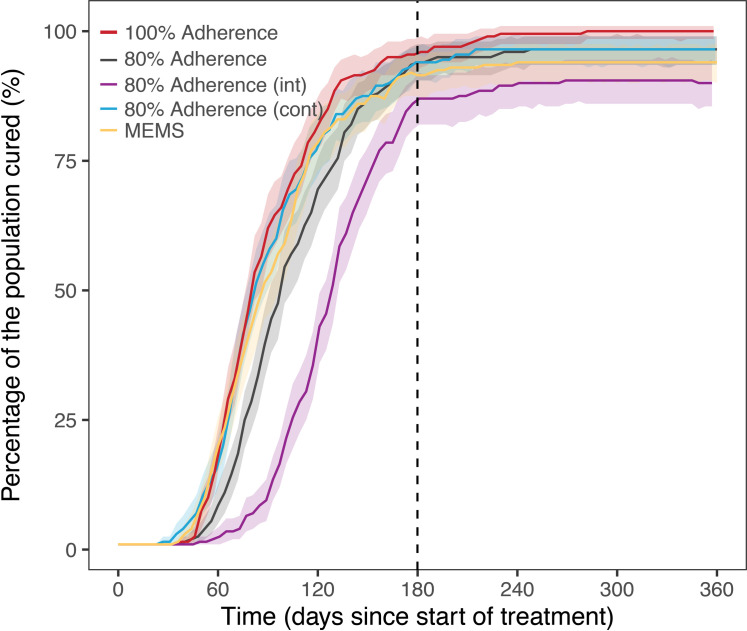
Population TB treatment outcome for different adherence patterns.Comparison of median patient outcomes for treatment of TB infection, with standard drug therapy (2HREZ/4HR) at 100% adherence, 80% adherence randomly spaced throughout treatment, 80% during intensive or continuation phase and simulations from medication event monitoring system (MEMS) data. Based on simulation of 5000 patients. Infection occurs 180 days before treatment.